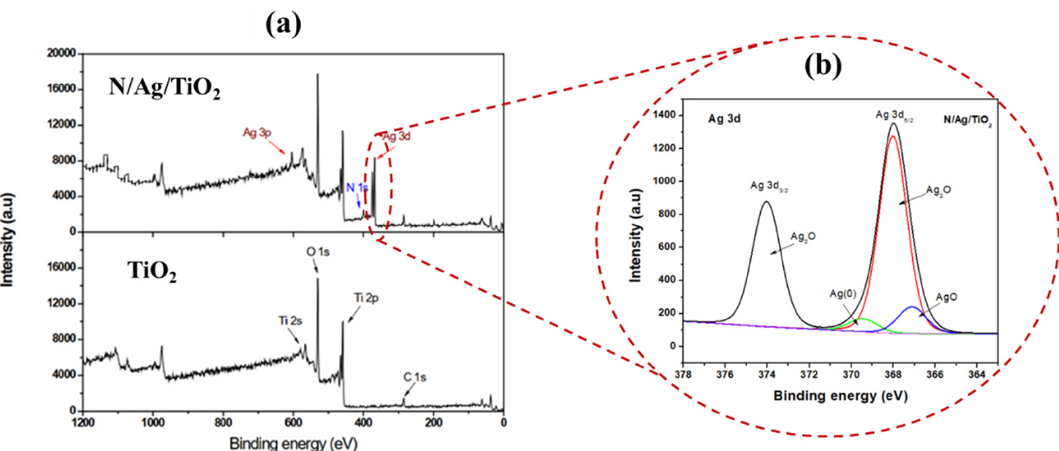
Figure A3. Shows the following: ( a ) Full scan XPS spectra of N/Ag/TiO 2 and Bare-TiO 2 photocatalysts and ( b ) high-resolution XPS spectra of Ag 3d.